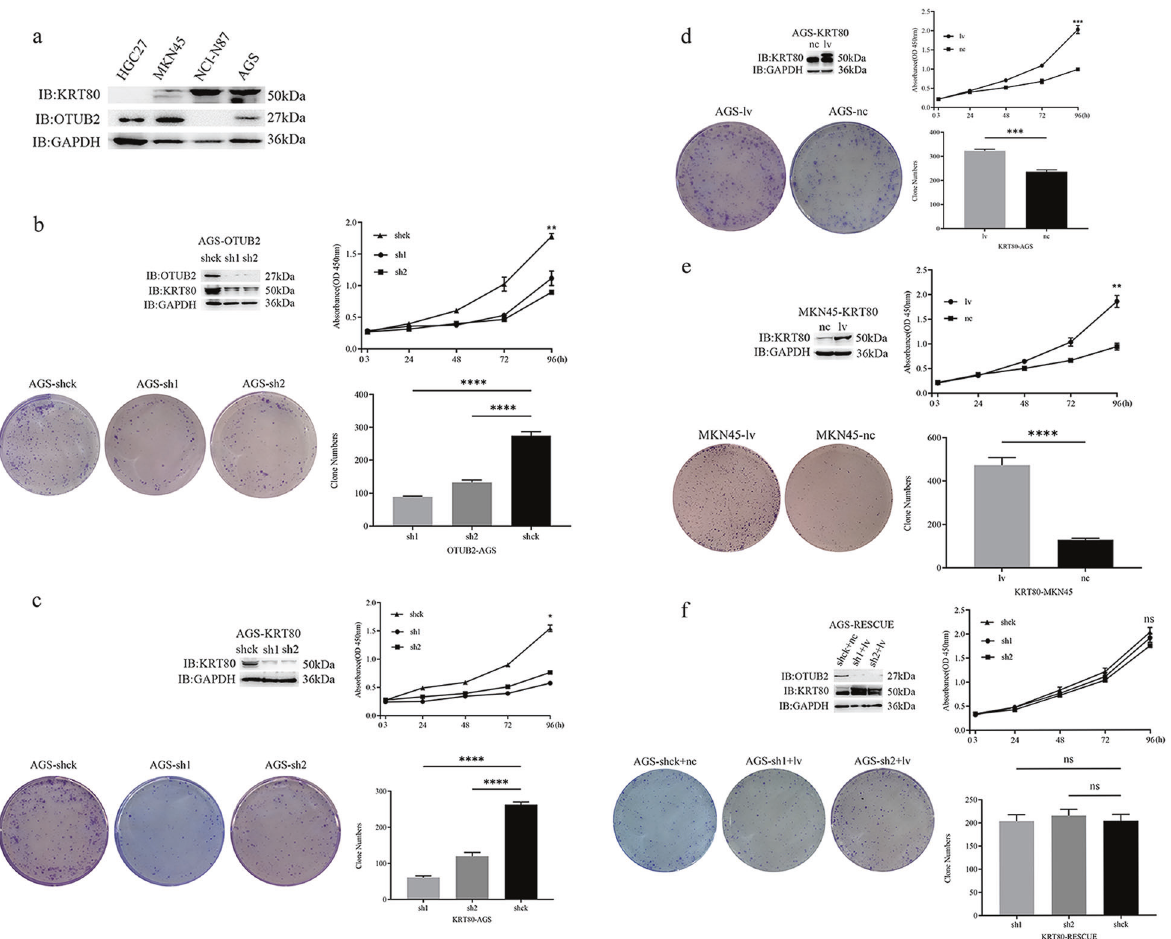
Fig. 3 OTUB2-promoting gastric cancer cell proliferation is coincident with KRT80 in vitro. a Western blotting analysis of OTUB2 and KRT80 expression in four gastric cancer cell lines. b – f Western blot analysis, CCK-8 assay, plate colony formation assay, and quanti fi cation of OTUB2 and KRT80 expression and cellular growth in AGS cells and MKN45 cells with stable OTUB2-knockdown, KRT80-knockdown, KRT80-overexpression, KRT80-overexpression, and rescued-KRT80 respectively. The number of gastric cancer cell clones was quanti fi ed. Error bars represent the mean ± SD of three independent experiments. * P < 0.05; ** P < 0.01; *** P < 0.001; **** P < 0.0001; ns not signi fi cant (Student ’ s t